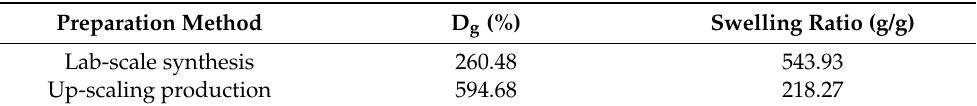
Table 1. D g and swelling ratio of SWA prepared from the lab-scale synthesis (at an optimized condition) and the up-scaling